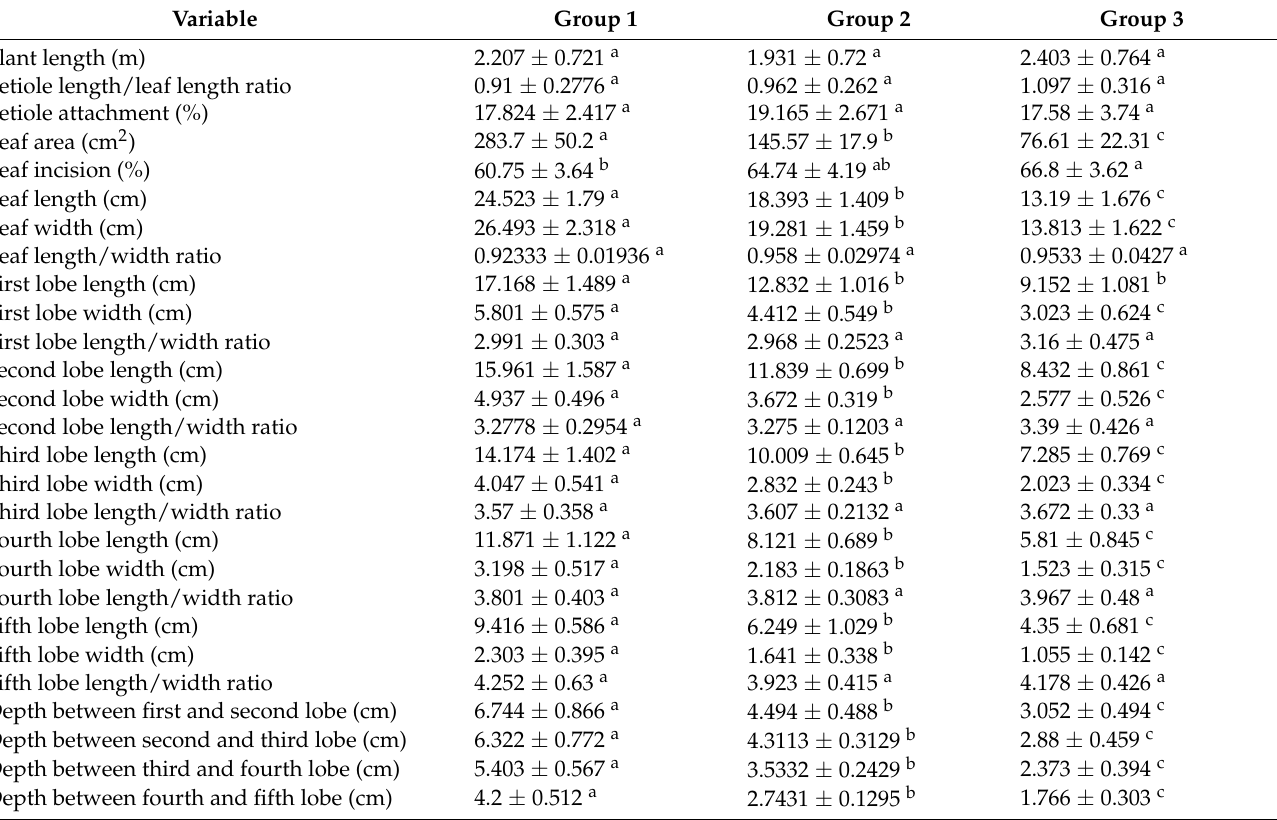
Table 4. One-way ANOVA results and pairwise comparisons between the three groups of Ricinus communis showing the significant morphological traits. Groups that share same letters